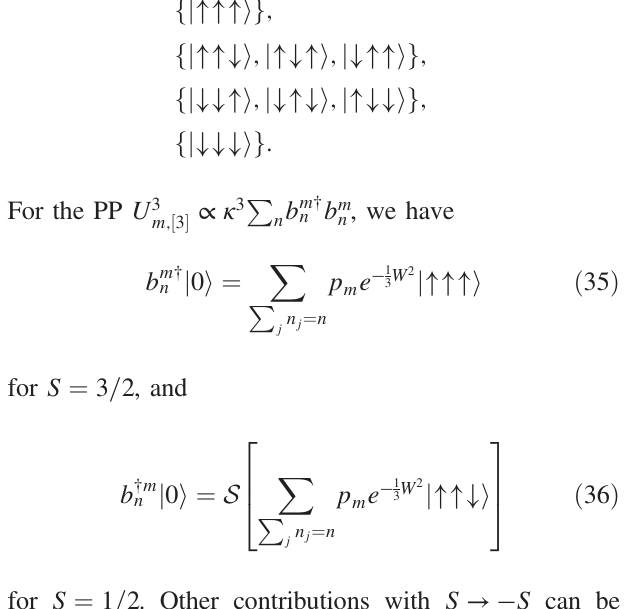
TABLE IV. Summary of the PP construction procedure for the multicomponent case. Examples of this procedure are given in Sec. V.